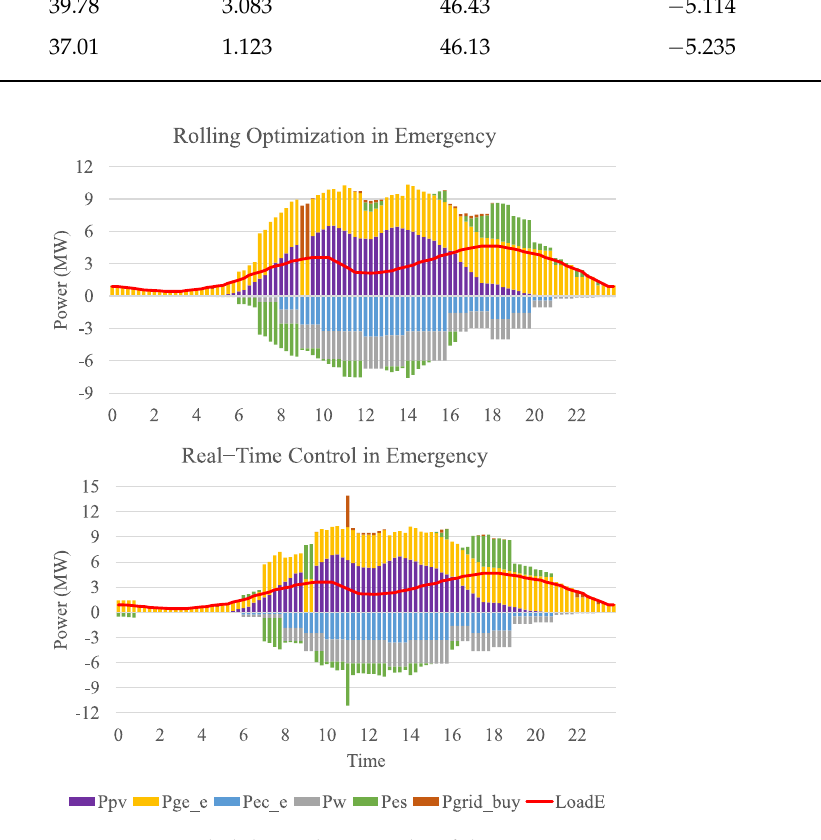
Figure 12. Detailed dispatching results of the IES in